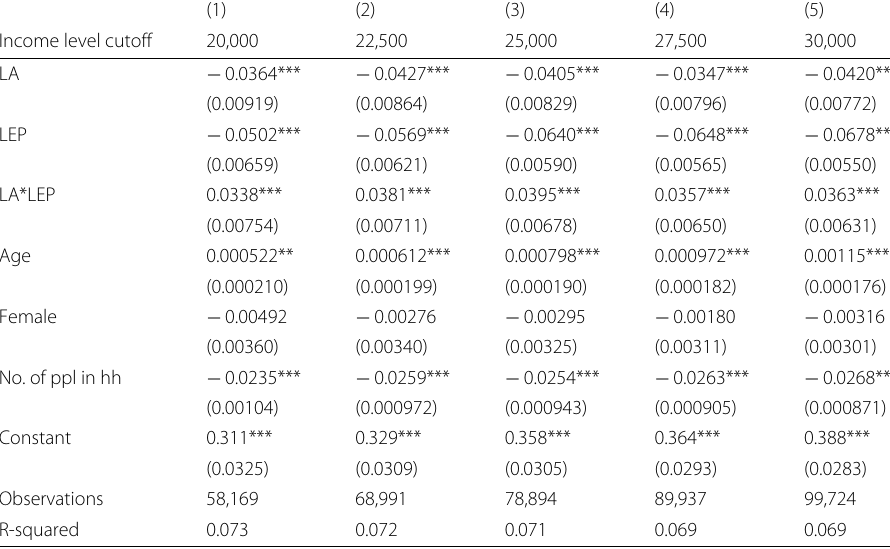
Table 5 Language access, insurance coverage, and crowd-out: private